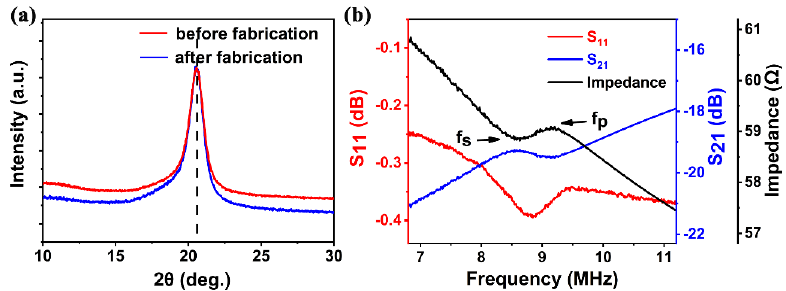
Figure 4. ( a ) Comparison of X -ray diffraction patterns of β -phase PVDF films before and after fabrication, showing no visible influence from fabrication processes; ( b ) S-parameter and impedance characteristic curve of FBAR device.